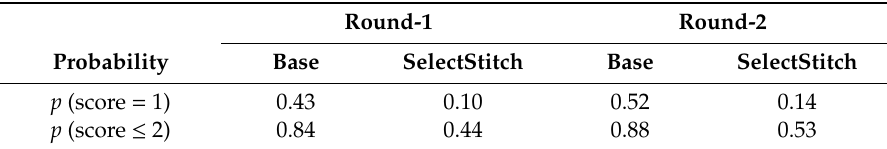
Table 3. Probability on Scoring. The p (score = 1) shows the probability of scoring 1 and p (score ≤ 2) shows the probability of scoring below 3.